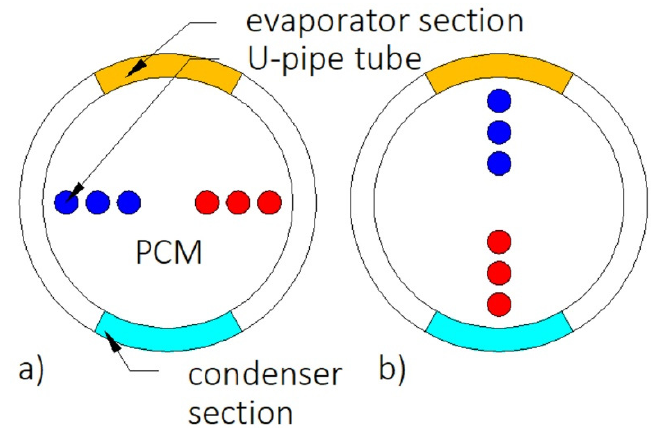
Figure 18. Cross-section of the heat exchanger with heat–pipe–shell and inclination angle of the HTF U-pipes: ( a ) 0, ( b ) 90° [151]. Table 9. Research on the other types of heat exchangers.